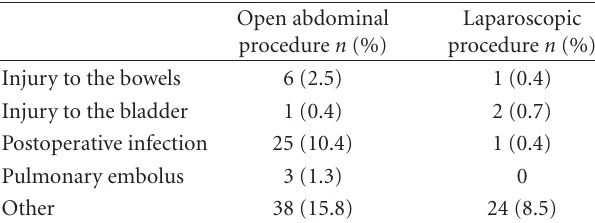
Table 2: Complications in women treated by open abdominal and laparoscopic